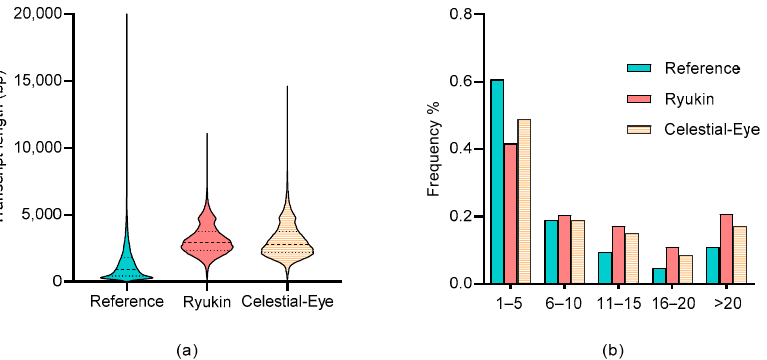
Figure 2. Comparison of transcript length and exon number of full-length transcriptome sequencing with reference genome. ( a ) Transcript length distribution of polished consensus reads; ( b ) the number of exons recovered by polished consensus reads.